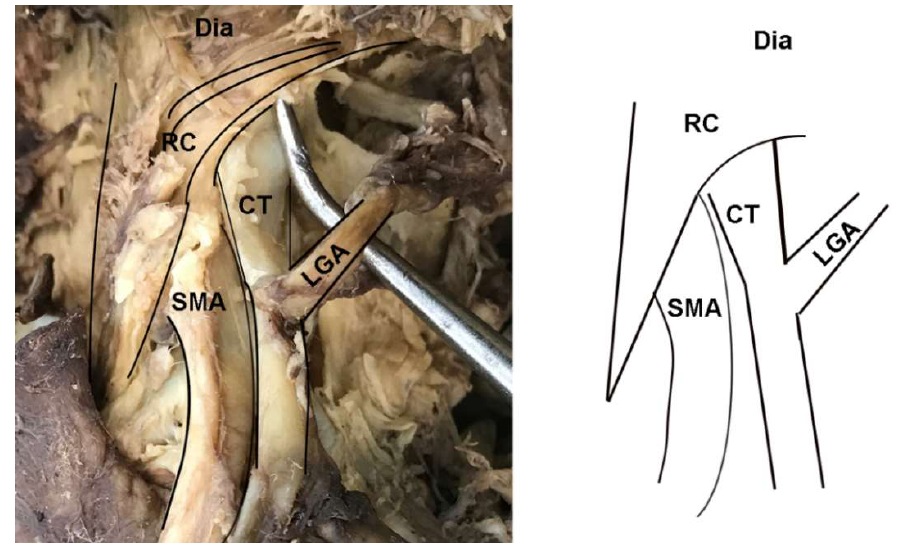
Figure 4. Dissection photo showing overlap of the celiac trunk by the right crus of the diaphragm: a) Photo; b) illustration. Abbreviations are as follows: CT = celiac trunk; Dia = diaphragm; LGA = left gastric artery; RC = right crus of diaphragm; SMA = superior mesenteric artery.